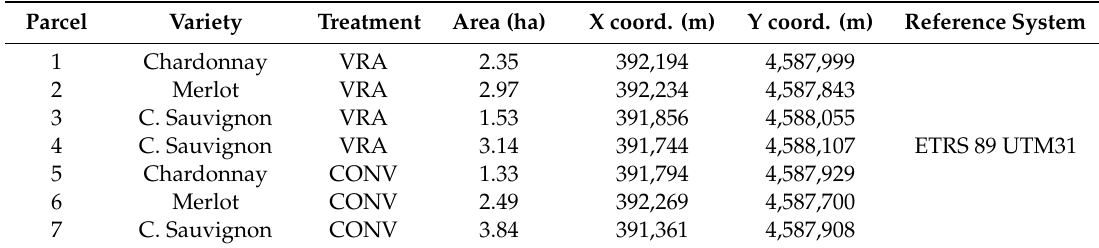
Table 1. Main characteristics of the vineyard parcels.